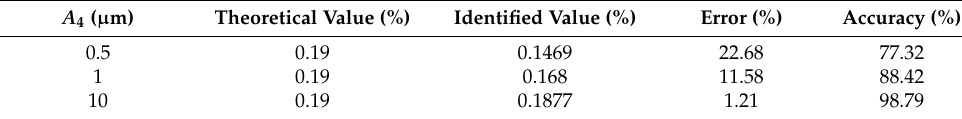
Table 3. Identified damping ratios with different steady-state amplitudes.